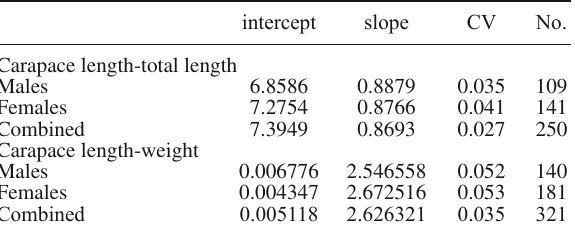
t able 5. – Parameters of the relationships carapace length vs total length and carapace length vs total weight for males, females and both sexes combined of Squilla mantis. CV, coefficient of variation.